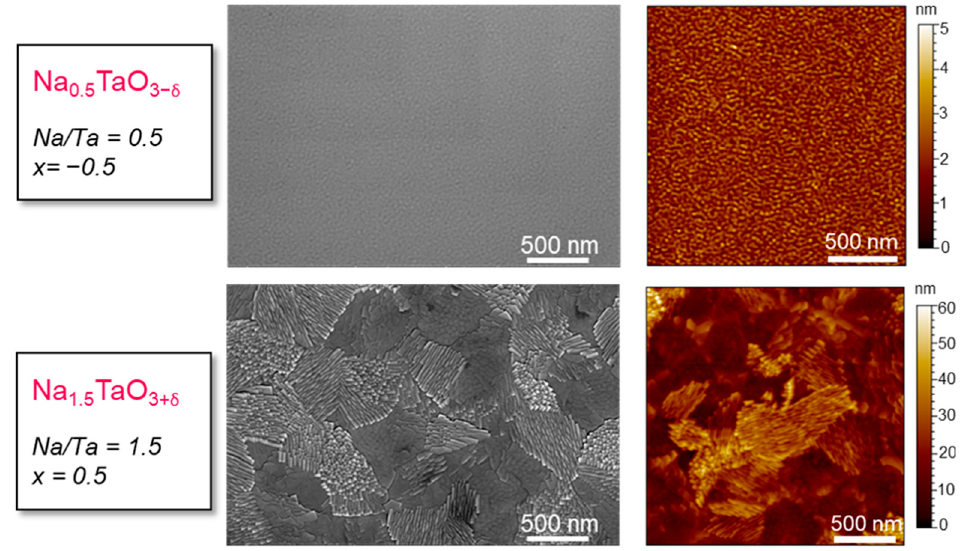
Figure 8. SEM (left) and AFM (right) images of Na 0.5 TaO 3 −δ and Na 1.5 TaO 3+ δ . The morphology con- Figure 8. SEM ( left ) and AFM ( right ) images of Na 0.5 TaO 3 − δ and Na 1.5 TaO 3+ δ . The morphology firms high crystallinity and the amorphous character of Na 1.5 TaO 3+ δ and Na 0.5 TaO 3 −δ , respectively.